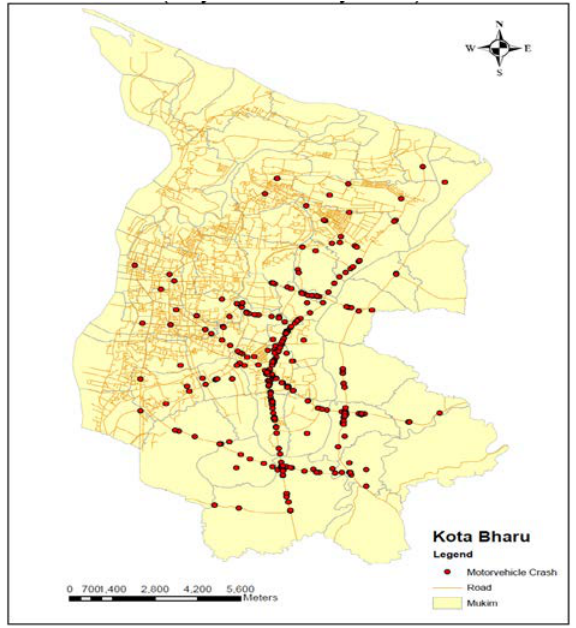
Figure 4: Geomapping of all road traffic injury cases by using ARCGIS ® software version 10.